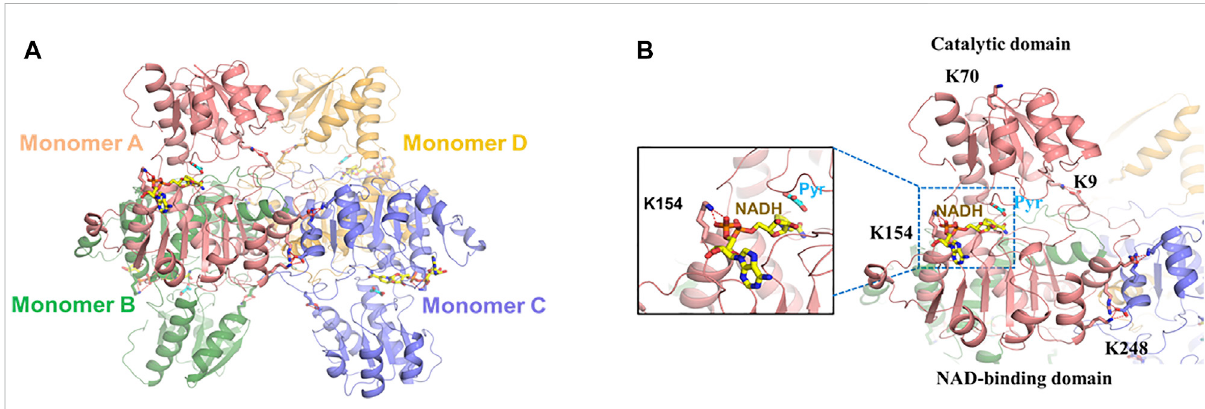
FIGURE 2 The 3D modelled structure of EcLdhA. (A) Quaternary structures of LdhA. (B) Location of the LdhA acetylated lysine sites, K70 is located at the distalregionofthecatalyticdomain,K154isresponsibleforbindingthecofactorofNADH,K9andK248formthesaltbridgeswithacidicaminoacids, Pyr: